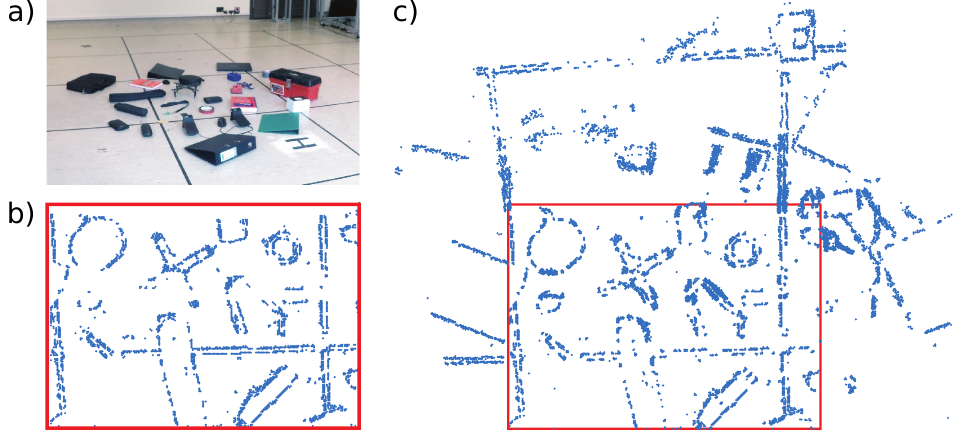
Figure 7. The scene used for the Objects test. ( a ) Frame capture of the scene consisting of various objects on the ground. ( b ) The feature map generated at initialization. Blue dots show features. The red box shows the sensor FoV. ( c ) The final map after the recording. New features have been added both inside and outside the initialization